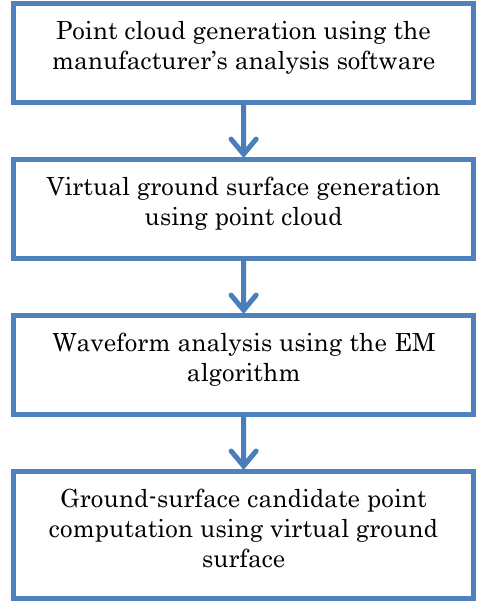
Figure 10. Virtual ground surface from a single course